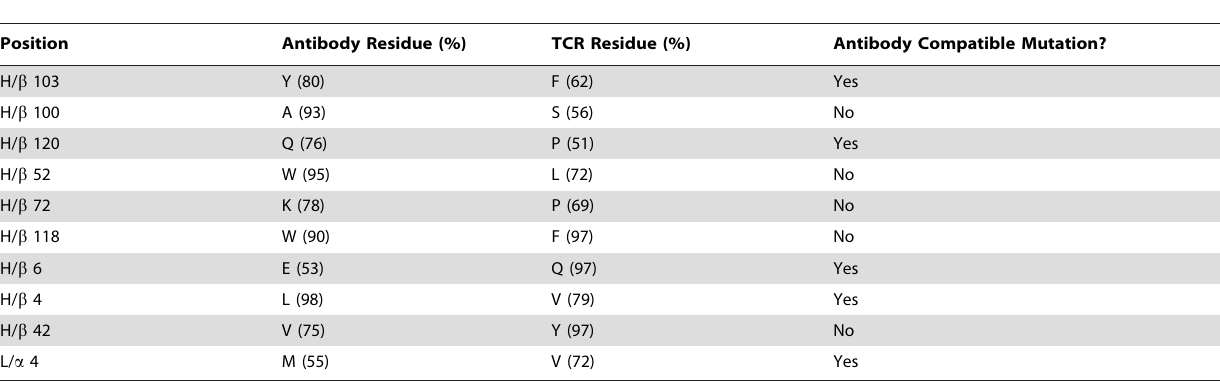
Table 2. Interface positions that are conserved in both TCRs and antibodies but with a different amino acid.